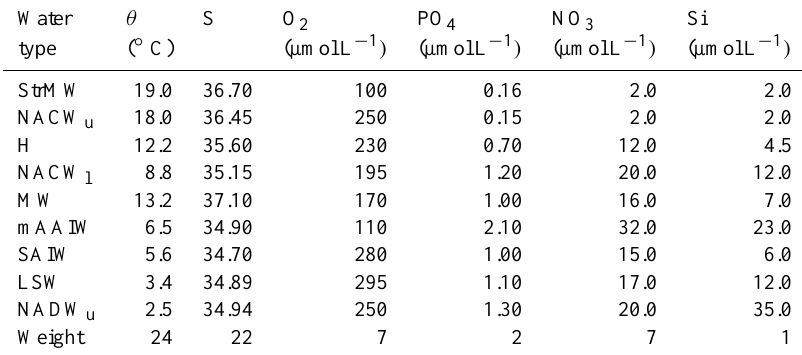
Table 2. Source water type characteristics for the subtropical mode water (StrMW), the North Atlantic Central Water (NACW u , H and NACW l ), the Mediterranean Water (MW), the modified Antarctic Intermediate Water (mAAIW), the Subarctic Intermediate Water (SAIW), the Labrador Sea Water (LSW), and the upper North Atlantic Deep Water (NADW u )